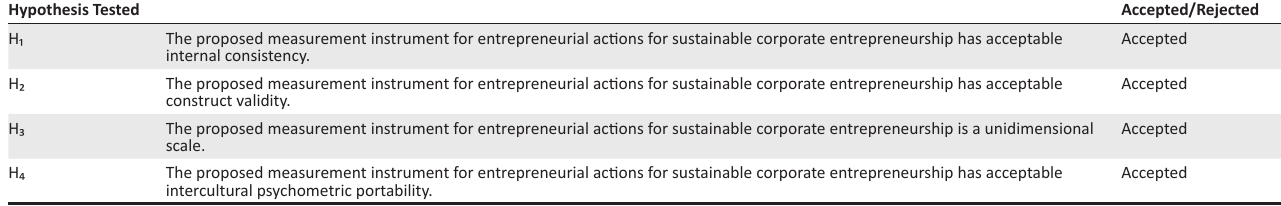
TABLE 4: Summary of results relating to tested hypotheses. Hypothesis